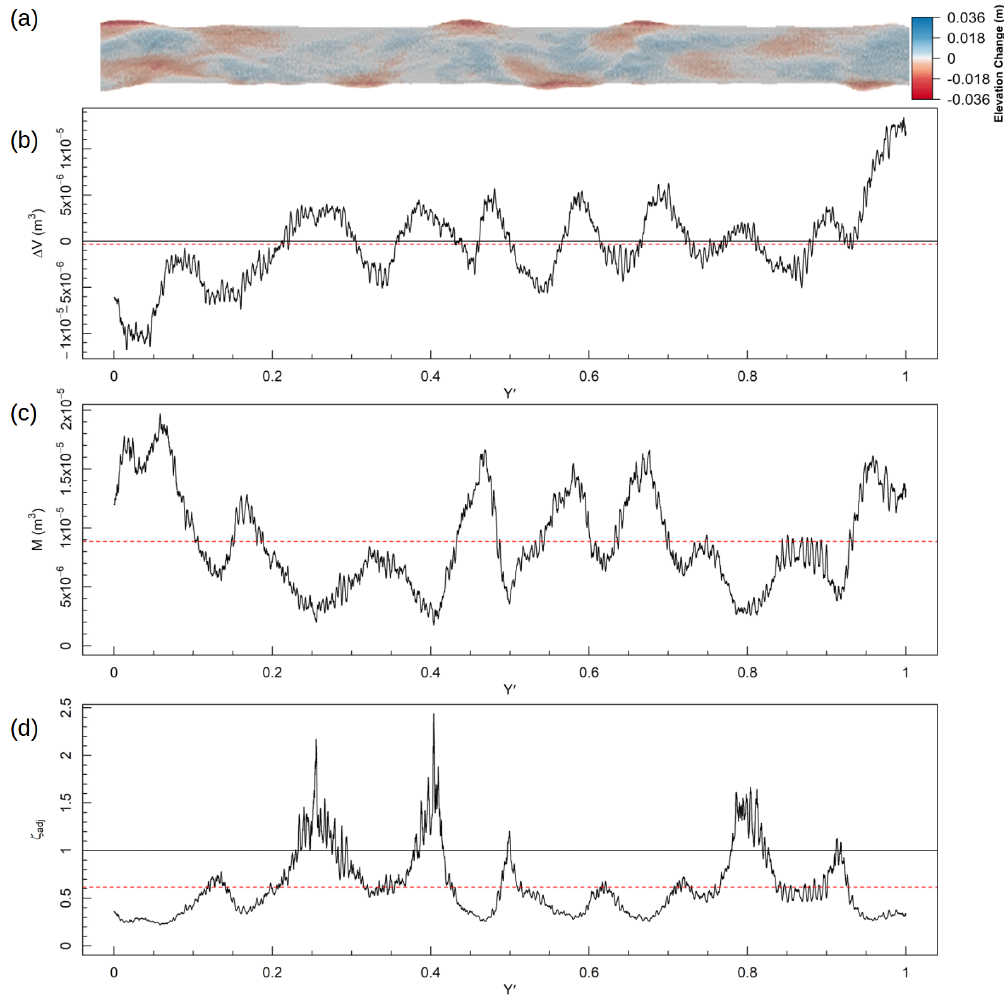
Figure 9. Example calculation of ζ for T = 15–30min in the mobile-bank experiment. See Fig. 8 for